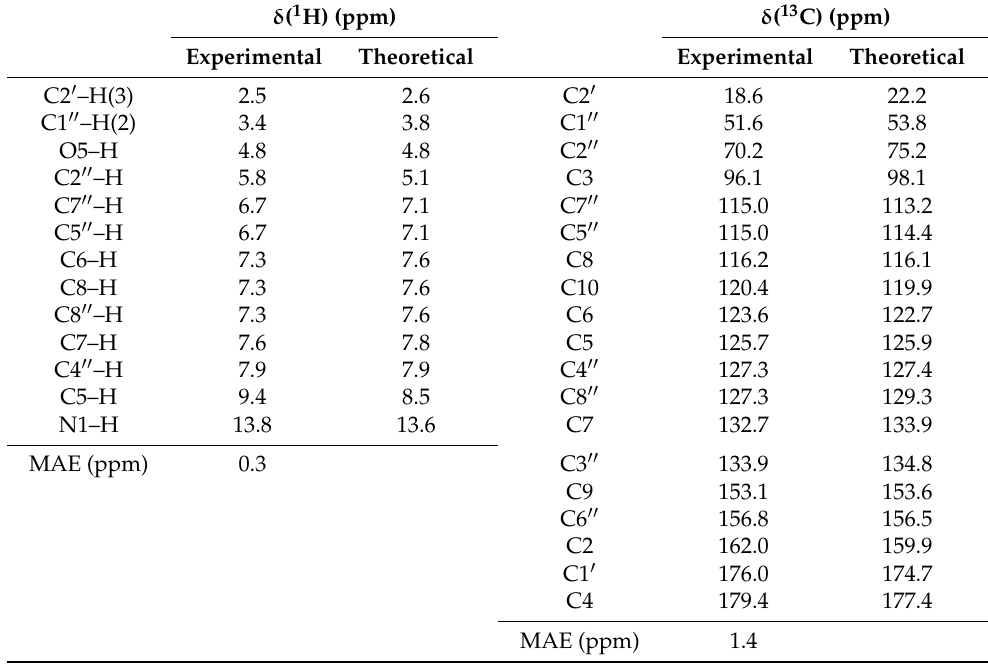
Table 3. Experimental and theoretical (at B3LYP-D3BJ/6-311++G(d,p), GIAO method) chemical shifts of L2 . The enumeration follows Figure 1.